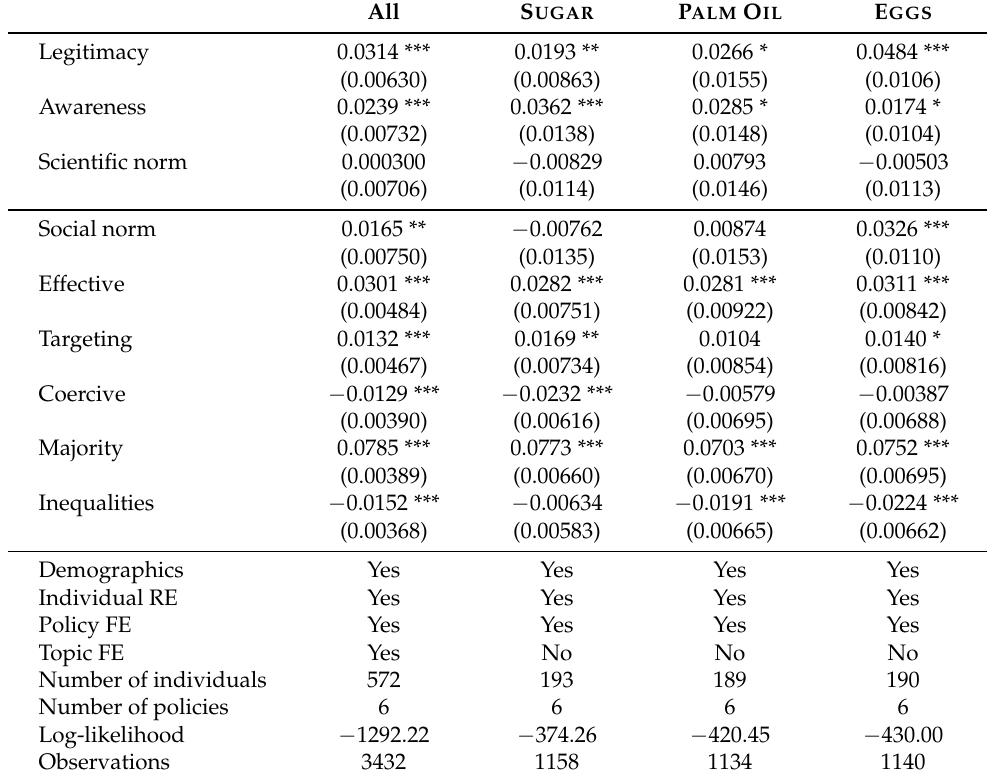
Table 7. Regression of hypothetical votes in favor of the